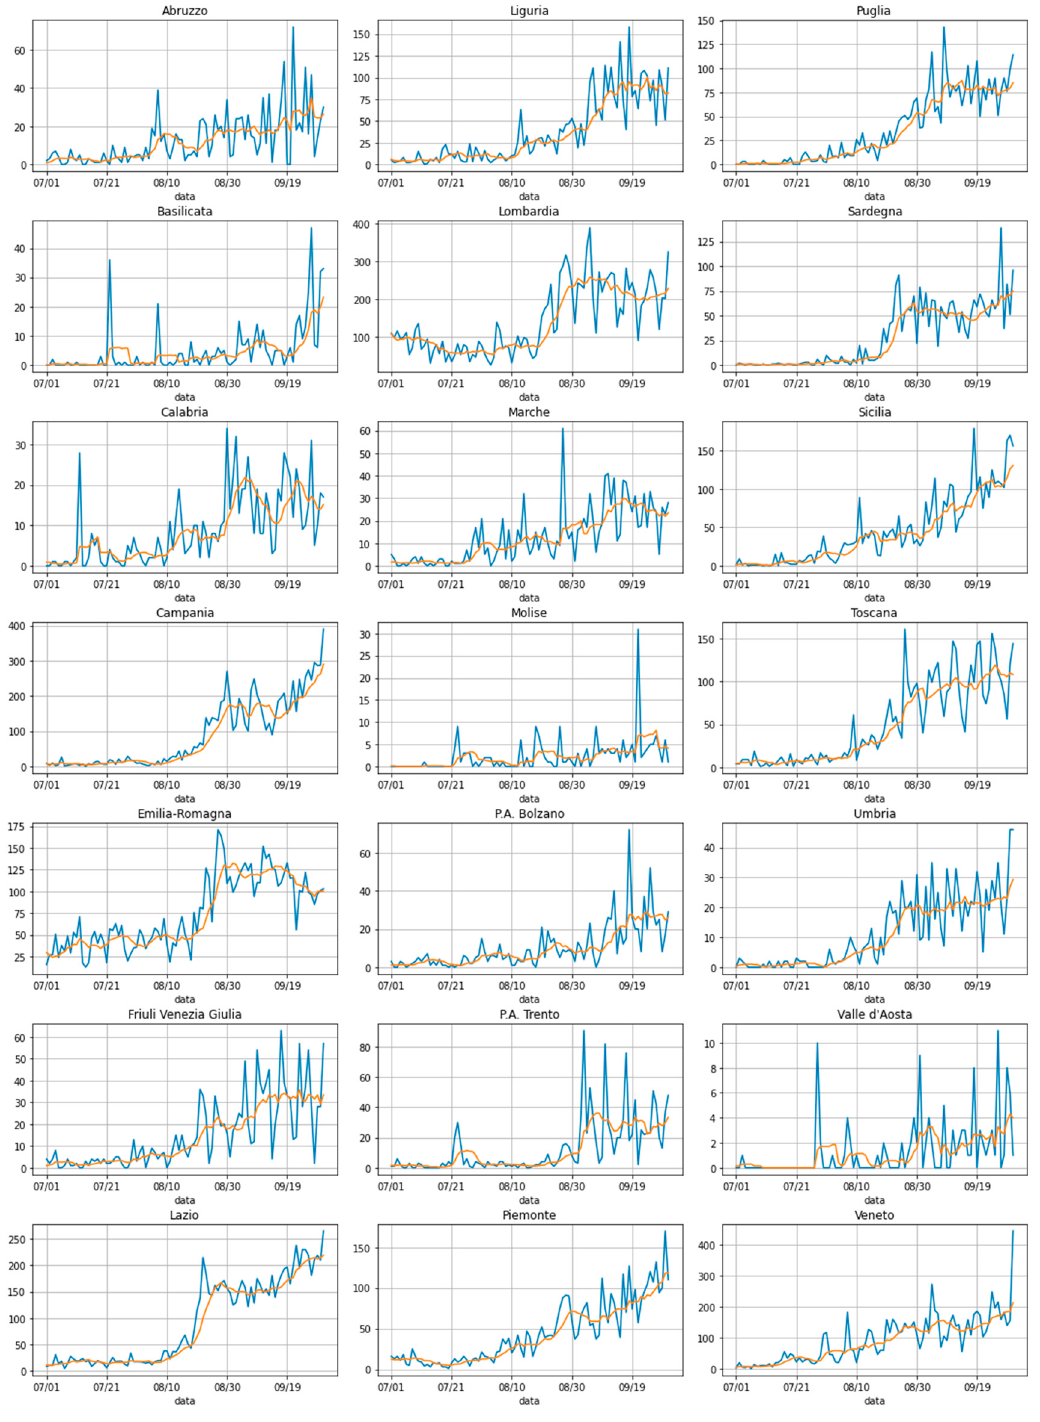
Figure 1. Number of new daily infection cases (in blue) and correspondent seven-day moving average (orange) for each of the 21 Italian regions, in the period between 1 July and 30 September. All data was collected from the dedicated GitHub repository created by the Italian government (https://github.com/pcm-dpc/COVID-19).